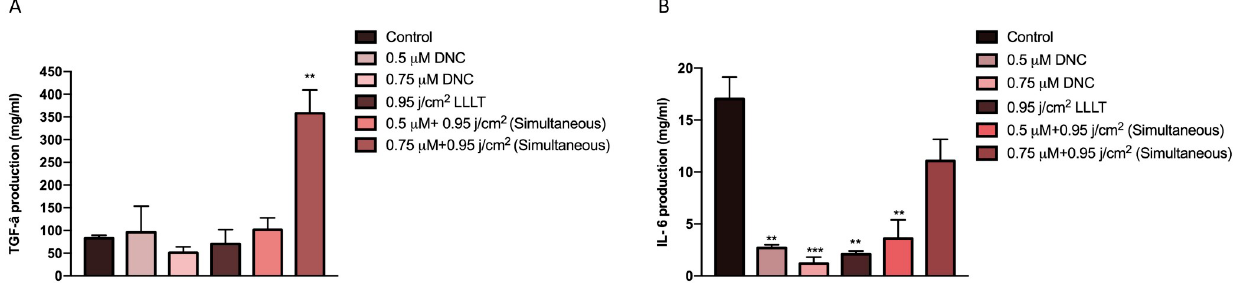
Fig 5. Quantification of TGF- β and IL-6 protein levels in cell culture supernatant from MEFs after 48h treatment with DNC and LLLT 450 nm and combination treatment using sandwich ELISA. (A) TGF- β , was significantly increased in the MEF treated with combination treatment (0.75 μ M DNC + 0.95 j/cm 2 LLLT at the same time) compared to the control and other groups. (B) IL-6, was significantly decreased in the MEF treated with DNC and LLLT alone and in combination compared to control group. Data are demonstrated as mean ± SEM; n = 3 ( �� : P < 0.01, ��� : P <